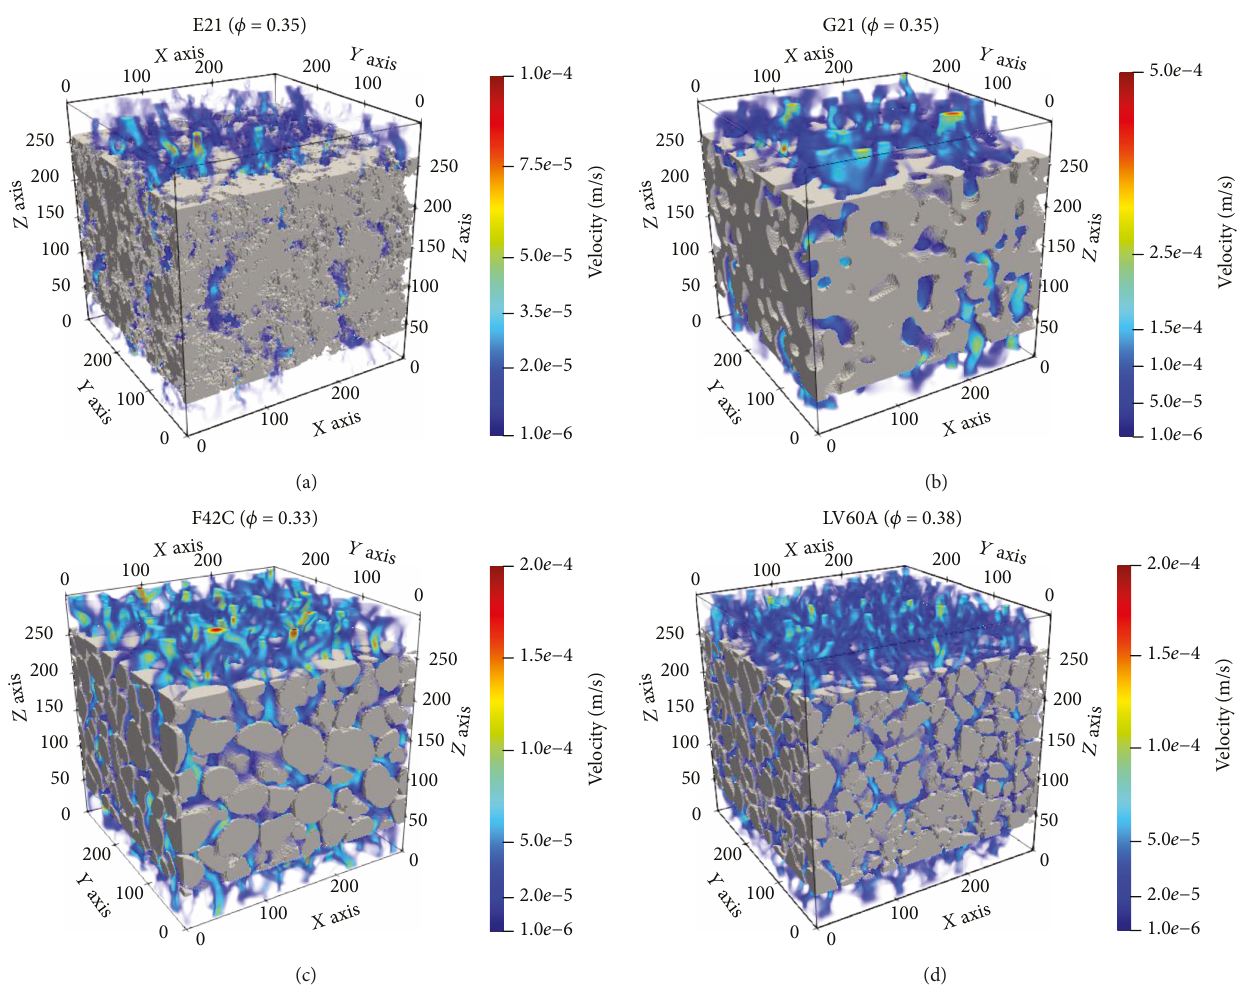
Figure 3: Visualization of porous medium structures and fl uid fl ow streamlines. (a) and (b) are two generated media with ξ = 0 21 mm and φ = 0 35 , whereas (c) and (d) are the scanned sandpacks with estimated ξ = 0 16 mm and φ = 0 33 (F42C) and ξ = 0 125 mm and φ = 0 38